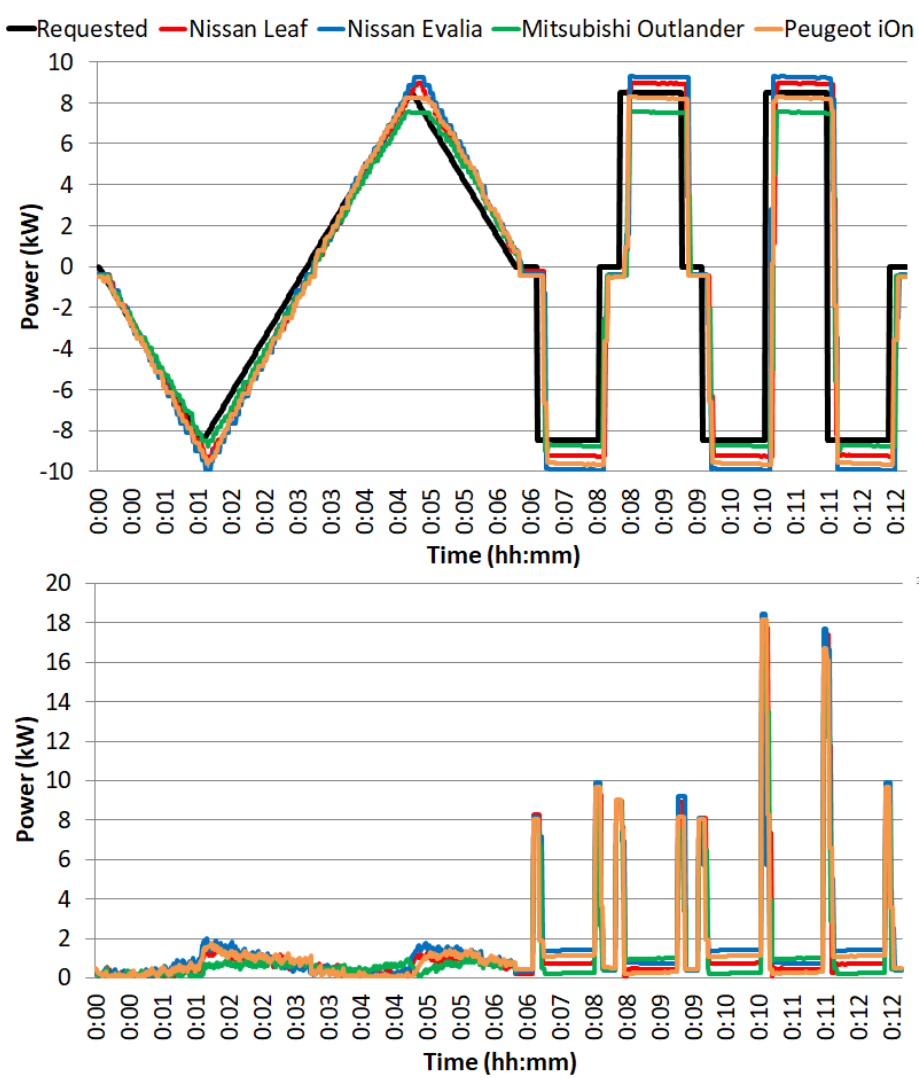
Figure 7. Parker performance test—active power, top : requested and provided power for test, bottom : absolute difference between requested and provided